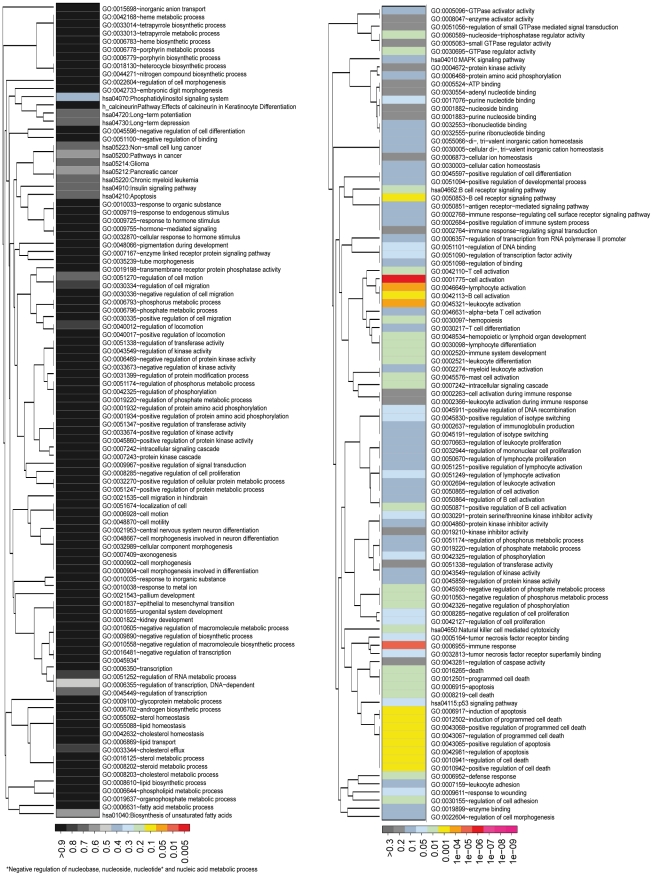
Functional annotation clustering of differentially expressed genes upon E/R KD.Visualization of the similarity of functional annotations that were determined by DAVID for down- (left) and up-regulated (right) genes upon E/R KD. The 100 most significant terms (ranked by P-value) are shown for both sets of annotation terms. Significance levels of functional terms are indicated by a color code shown at the bottom of the figure. Due to large differences in the range of P-values for the functional groups resulting from up- and down-regulated genes upon KD, a different color-scheme was used in each panel.